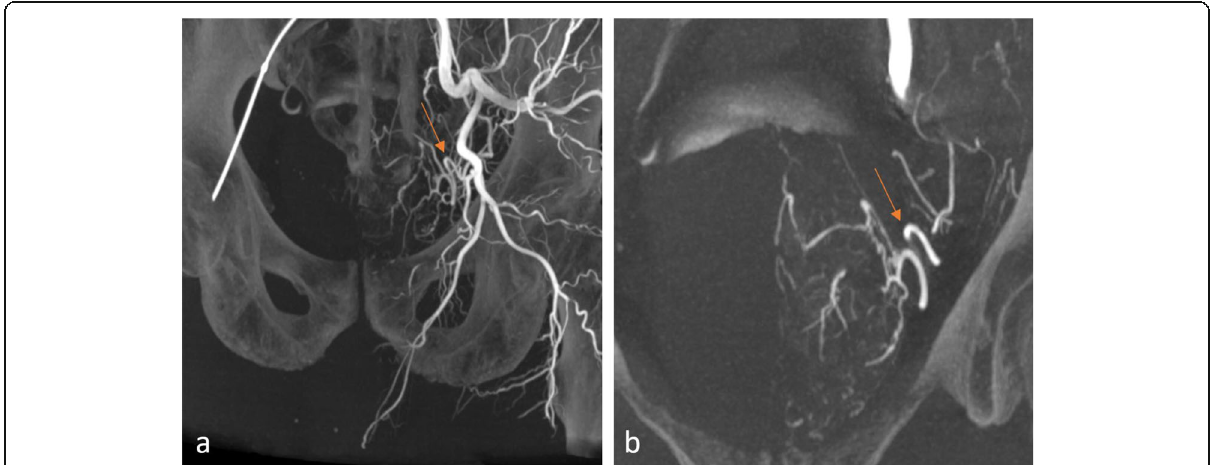
Fig. 2 Proximal CBCT. Five seconds CBCT acquisition, injection from left internal iliac artery (Discovery IGS 740, GE Healthcare, Chicago, IL). Maximum Intensity Projection (MIP) coronal views showing the left pelvic arterial vascular anatomy ( a ) and the left prostatic artery (arrow) and prostate gland blush ( b